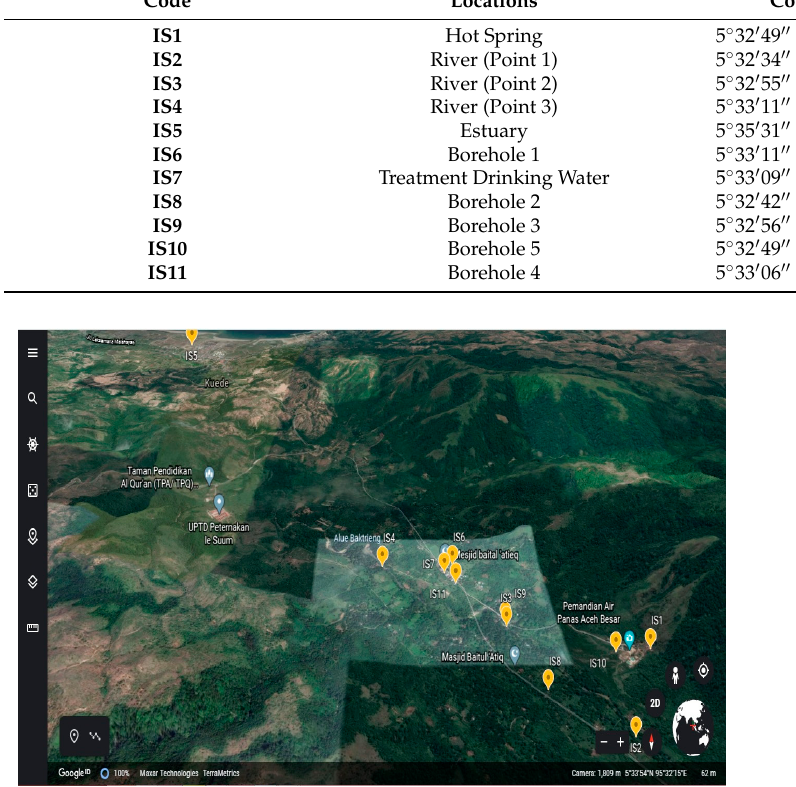
Figure 1. Sampling points based on Google Earth satellite image.